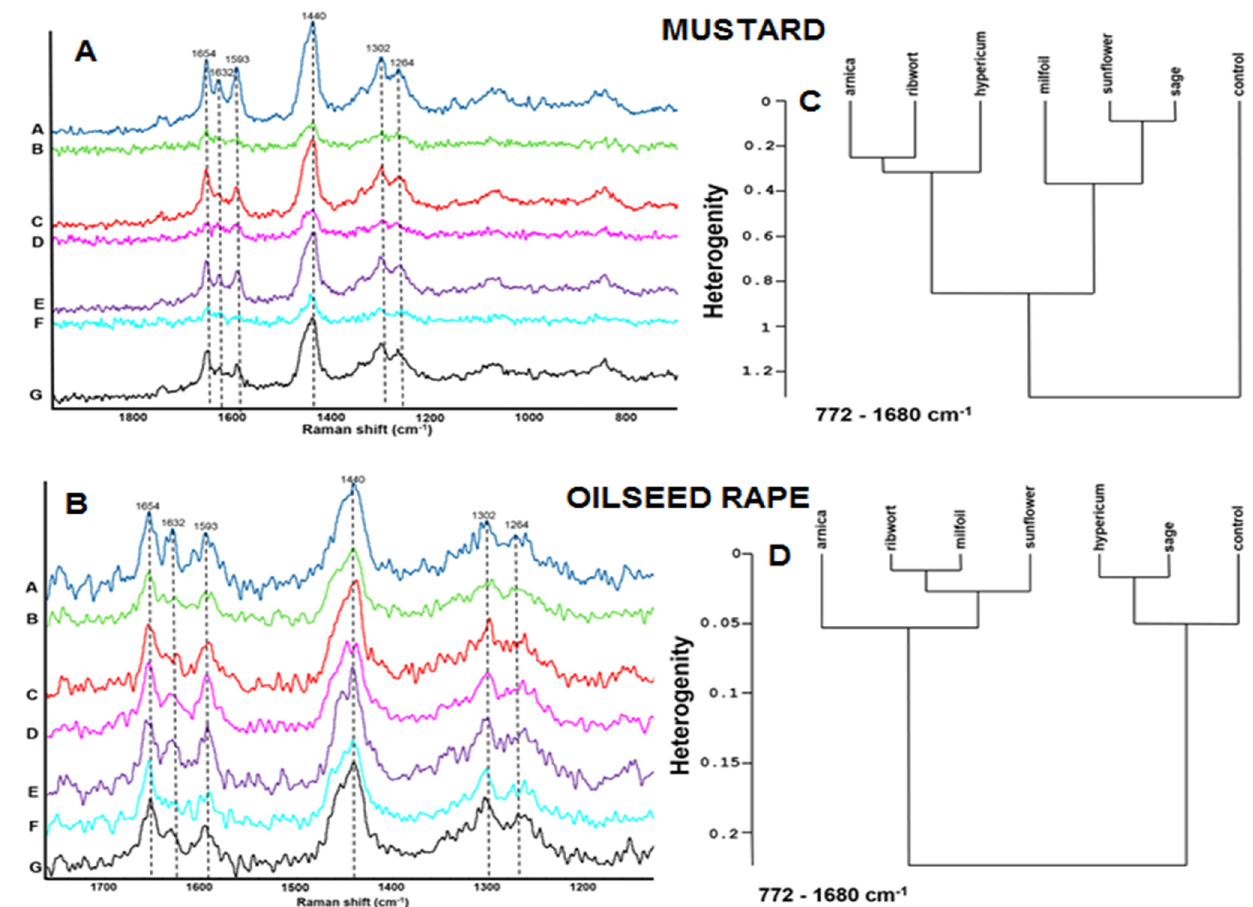
Figure 7 . FT-Raman spectra showing the chemical composition of seedlings cotyledons of the white mustard ( A ) and oilseed rape ( B ) that were growing on herbal extracts: A—arnica (blue line), B— ribwort (green line), C—hypericum (red line), D—milfoil (pink line), E—sunflower (violet line), F—sage (light blue line), G—water (control) (black line), n = 10. Hierarchical cluster analysis of the FT-Raman spectra of the white mustard ( C ) and oilseed rape ( D ).